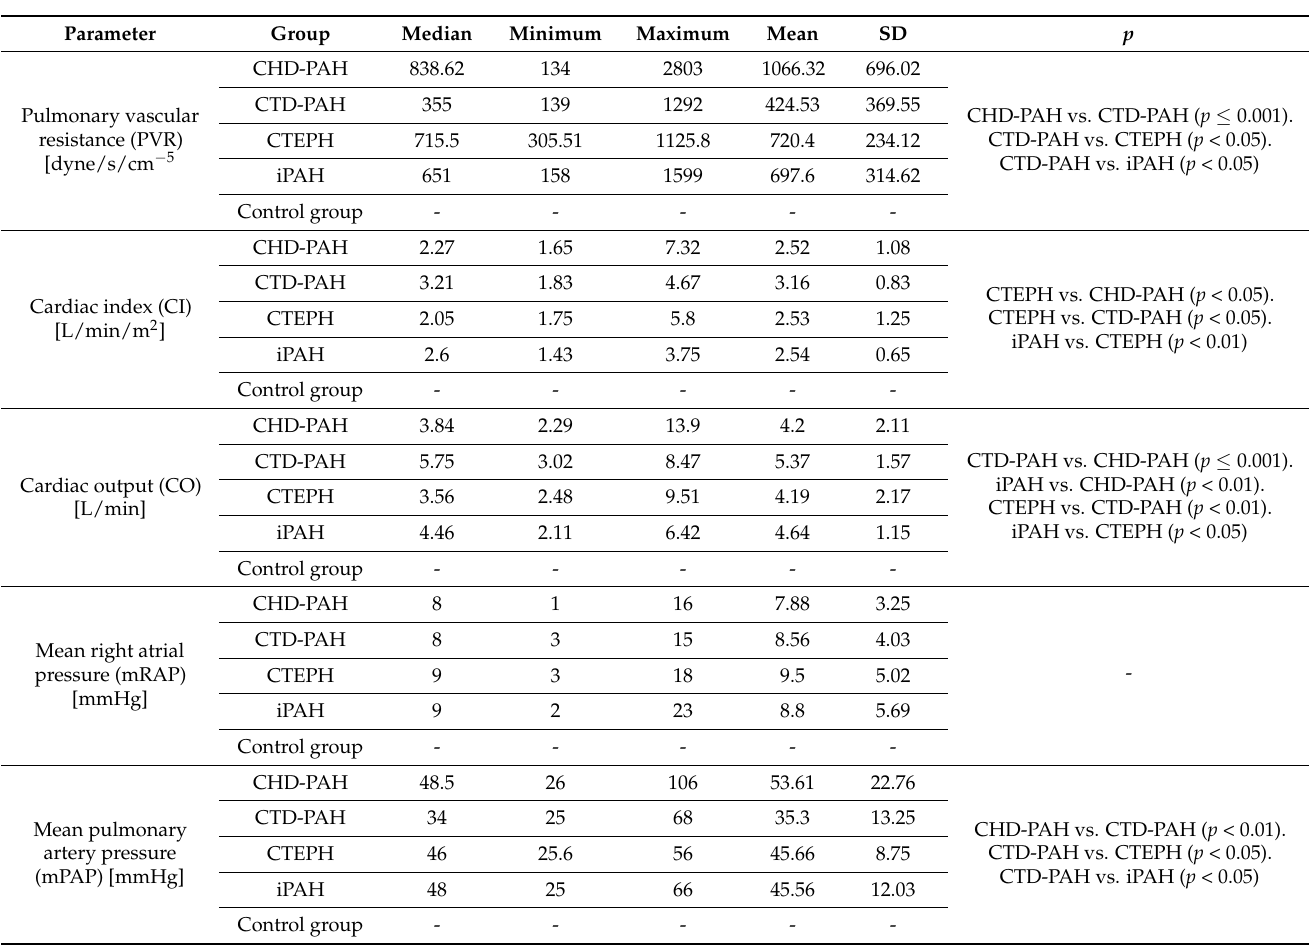
Table 3. Basic hemodynamic parameters assessed during cardiac catheterization and echocardiogra- phy in patients with CHD-PAH, CTD-PAH, CTEPH and